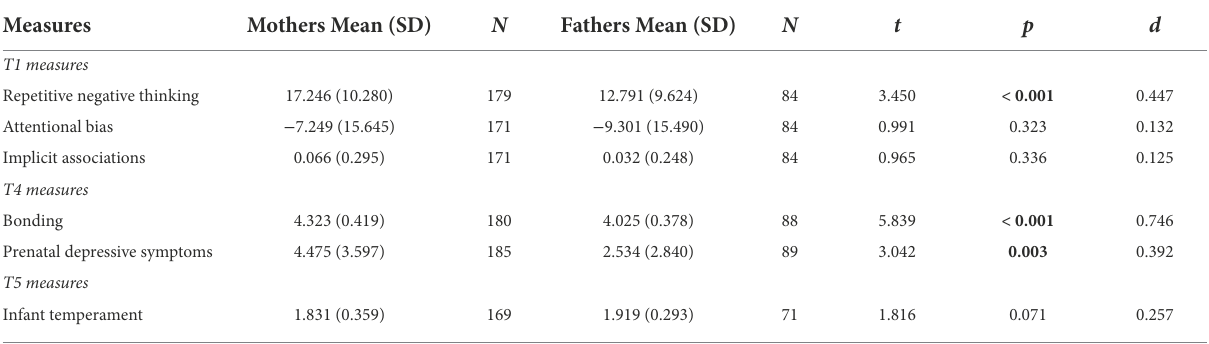
TABLE 3 Difference between mothers and